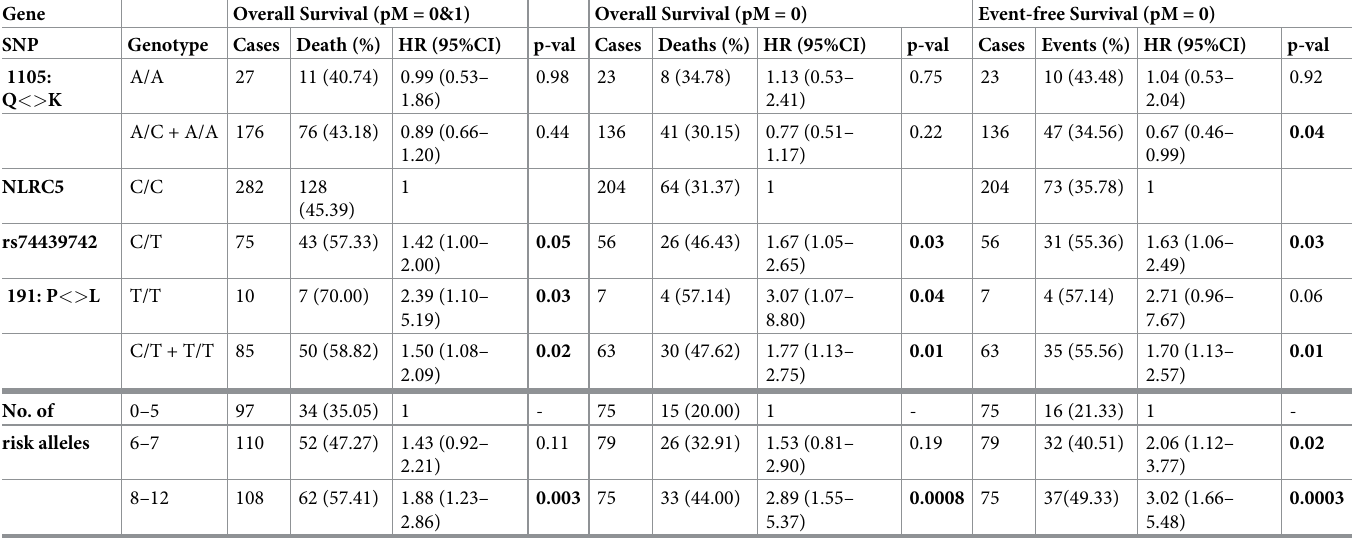
genotypes, DACHS data according to allelic probabilities. Despite the promising initial results, neither the associations for CRC risk nor the associations for CRC survival were replicated in the GWAS sets. We also tested the additive models in the DACHS population, but no associa- tion was evident (data not shown).